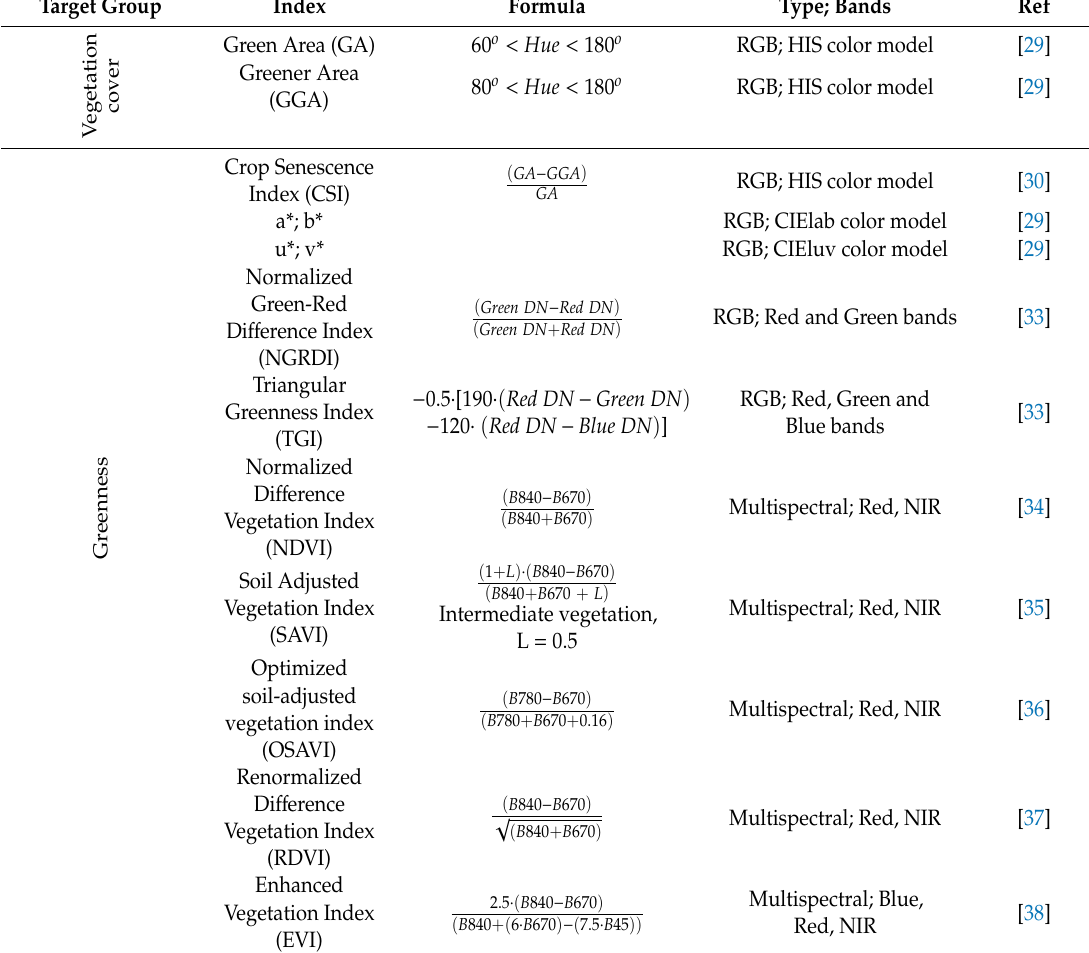
Table 4. Indexes derived from the RGB and multispectral cameras. The wavelengths used in the formulation of the multispectral indexes have been adapted slightly based on the multispectral micro-MCA Tetracam camera. * Note that for the PRI index, B550 is used instead of the original B531 by the cited reference